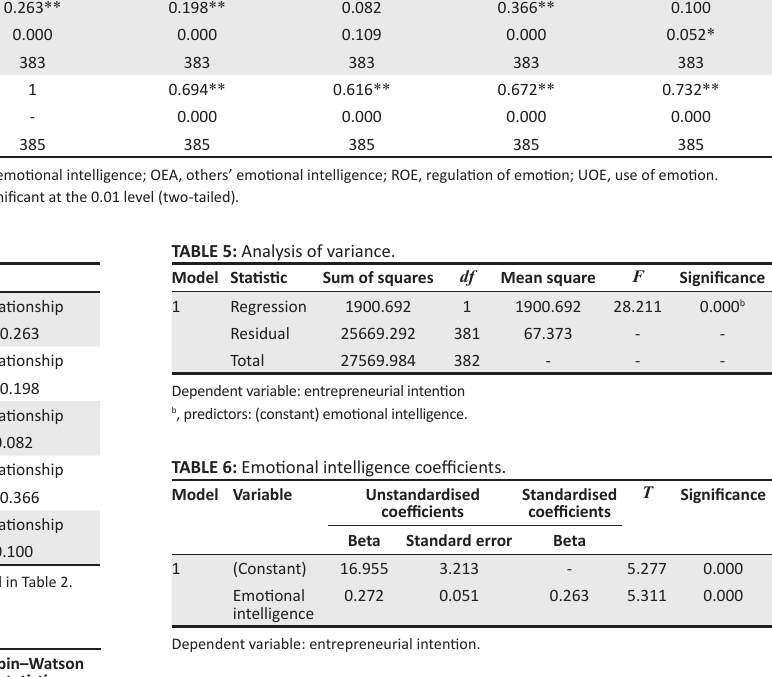
TABLE 2: Correlations. Variable Statistical test